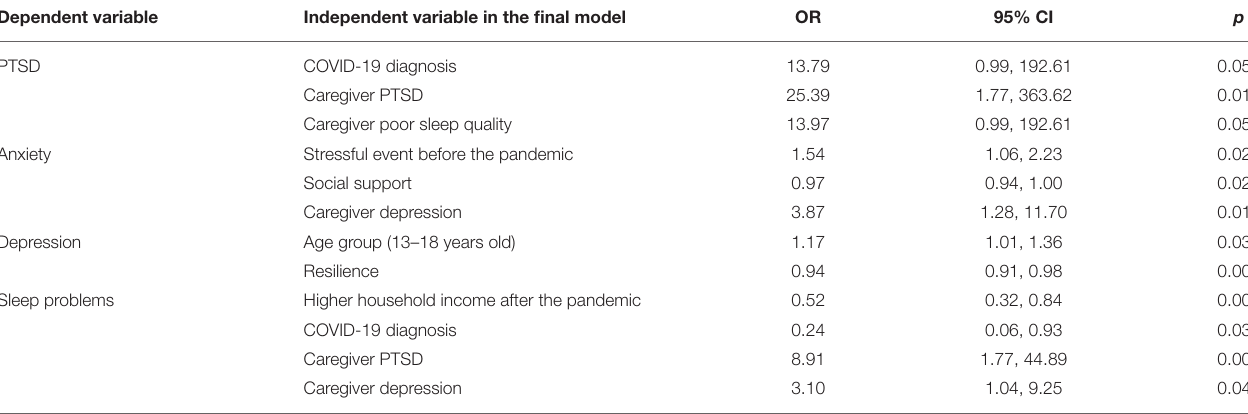
TABLE 3 | Risk factors associated with psychiatric symptoms in children and adolescents ( n =